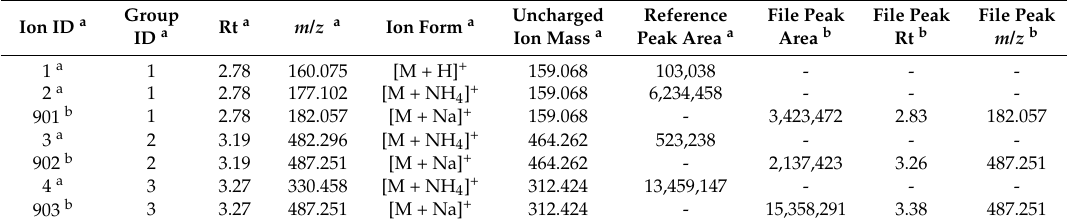
Table 2. Detail of an output feature matrix generated by matching a target chromatogram to the reference feature list from Table 1. The columns “Ion Charge” and “Ionization Mode” have been omitted for simplicity. Features 901–903 are newly generated ion forms that were not contained in the reference list. Trying to align the target chromatogram to the reference without accounting for the formation of different ion species would have resulted in no matches for the displayed